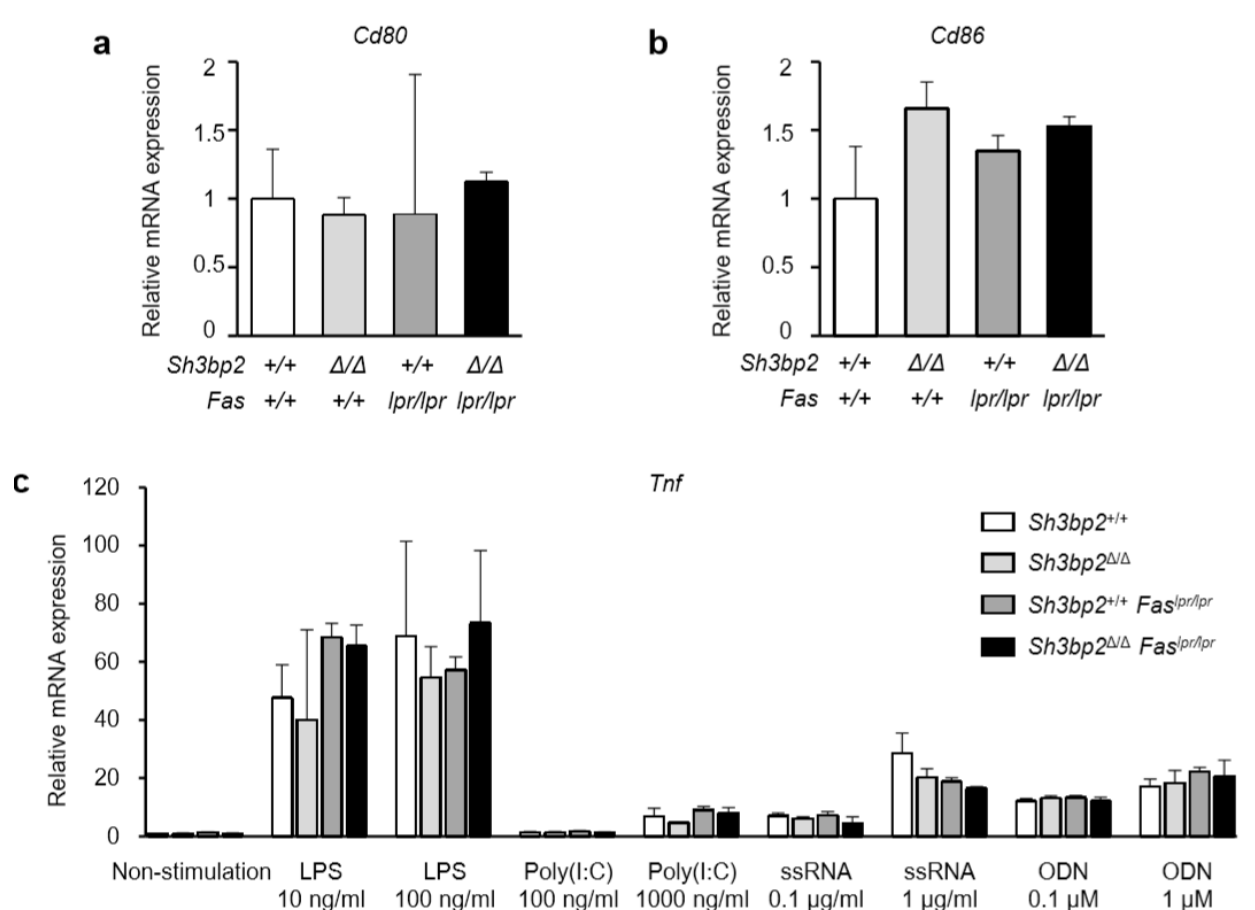
Figure A6. Gene expression patterns in bone marrow-derived macrophages. Bone marrow cells were isolated from the indicated mice and cultured with M-CSF. Gene expression levels in the yielded bone marrow-derived macrophages were determined by quantitative real-time PCR analysis. Expression levels of Cd80 ( a ) and Cd86 ( b ) at the basal state. ( c ) Bone marrow-derived macrophages were treated with TLR ligands for 6 h, and Tnf mRNA expression levels were determined. Values are presented as the mean ± SD. LPS, lipopolysaccharide; poly(I:C), polyinosinic-polycytidylic acid; ssRNA, single-stranded RNA; ODN, oligodeoxynucleotide.